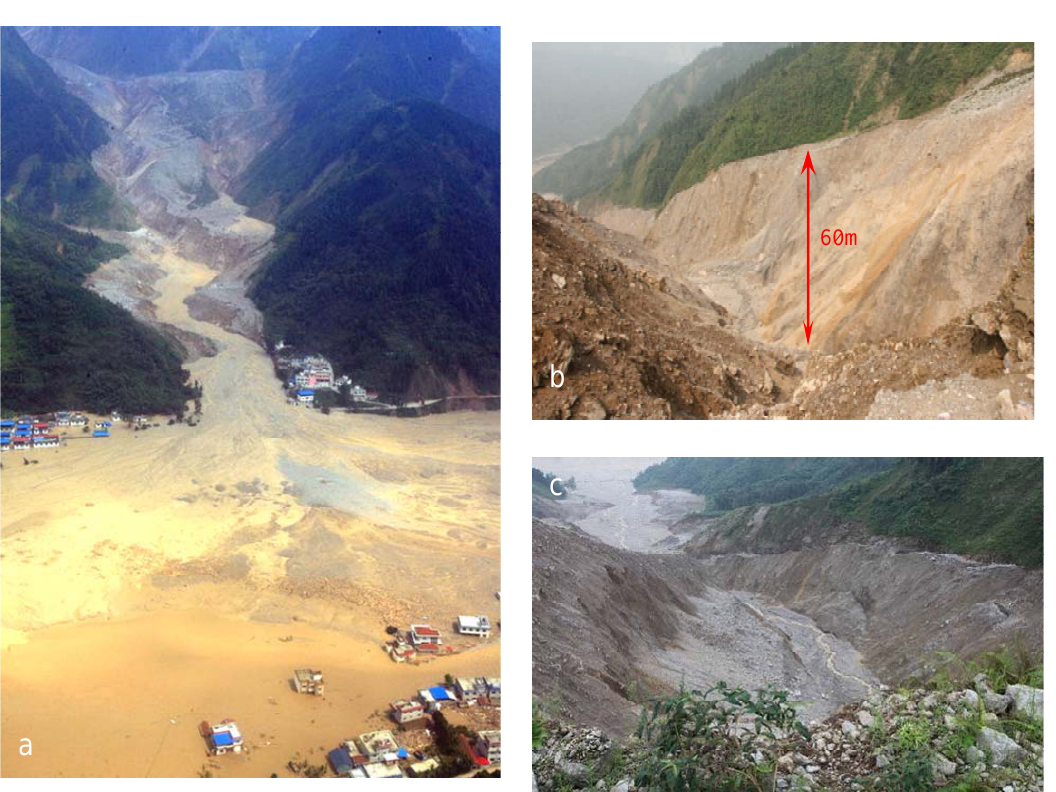
Fig. 6. Photos of the Wenjia gully 8.13 debris flow ( (a) : overview; (b) : channel erosion in the Wenjia gully; (c) : local widening by slope